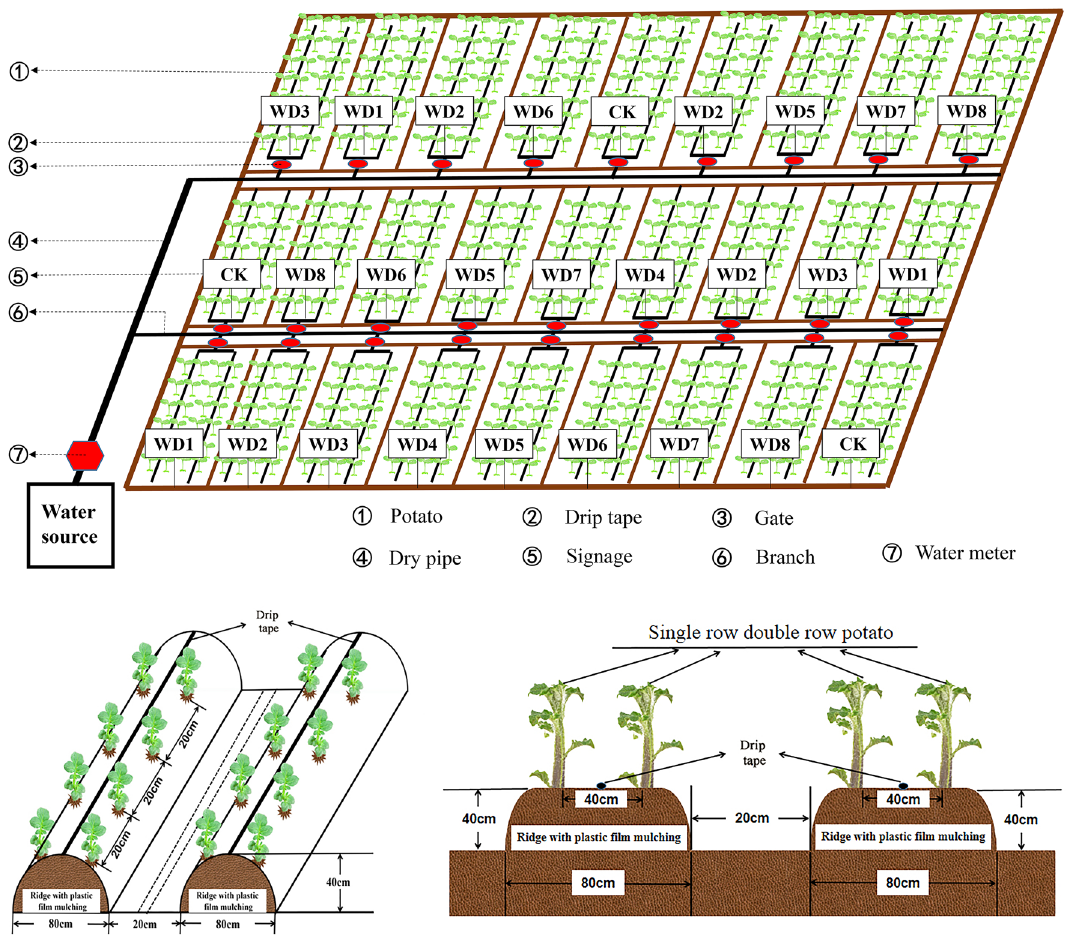
Figure 5. Cultivation of potatoes with regulated deficit drip irrigation on ridges under plastic film mulching.